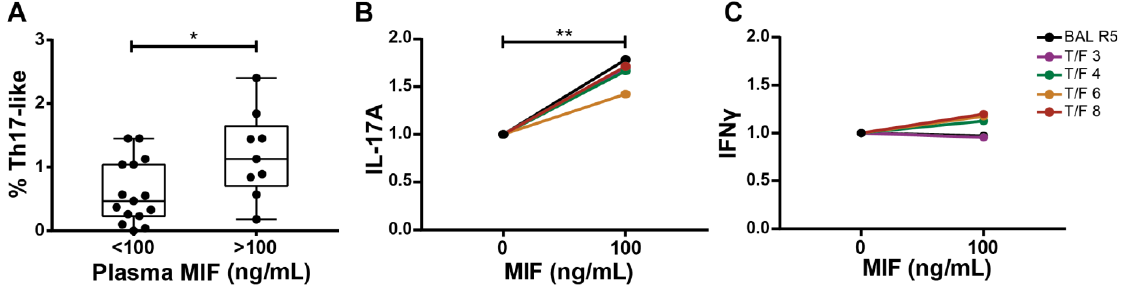
Figure 7. Association between MIF concentration in plasma and the proportion of IL-17A-expressing CD4TL in PBMCs, both derived from PWH. ( A ) Ex vivo IL-17A-expressing CD4TL percentage in PBMC from PWH segregated by low (<100 ng/mL) or high (>100 ng/mL) MIF plasma concentration. Data represent the median ± IQR25-75 of 15 donors. Data analysis was performed with a Mann – Whitney test. * p < 0.05. ( B ) Concentration of soluble IL-17A in MIF-stimulated co-cultures after five days of treatment with 100 ng/mL of MIF. MDM infection was performed with T/F HIV strains. Data show the average of means of at least three independent experiments with four different T/F HIV strains and the BAL R5 strain as a control, each one performed in triplicate, relative to the untreated control. Data analysis was performed with a Mann – Whitney test ** p < 0.01. ( C ) Concentration of soluble IFNγ in MIF -treated co-cultures after five days of treatment with 100 ng/mL of MIF with T/F HIV-strain-infected MDMs. Data show the average of means of at least three independent experiments with four different T/F HIV strains and the BAL R5 strain as a control, each one performed in triplicate, relative to the untreated control. Data analysis was performed with a Student’s t -test.